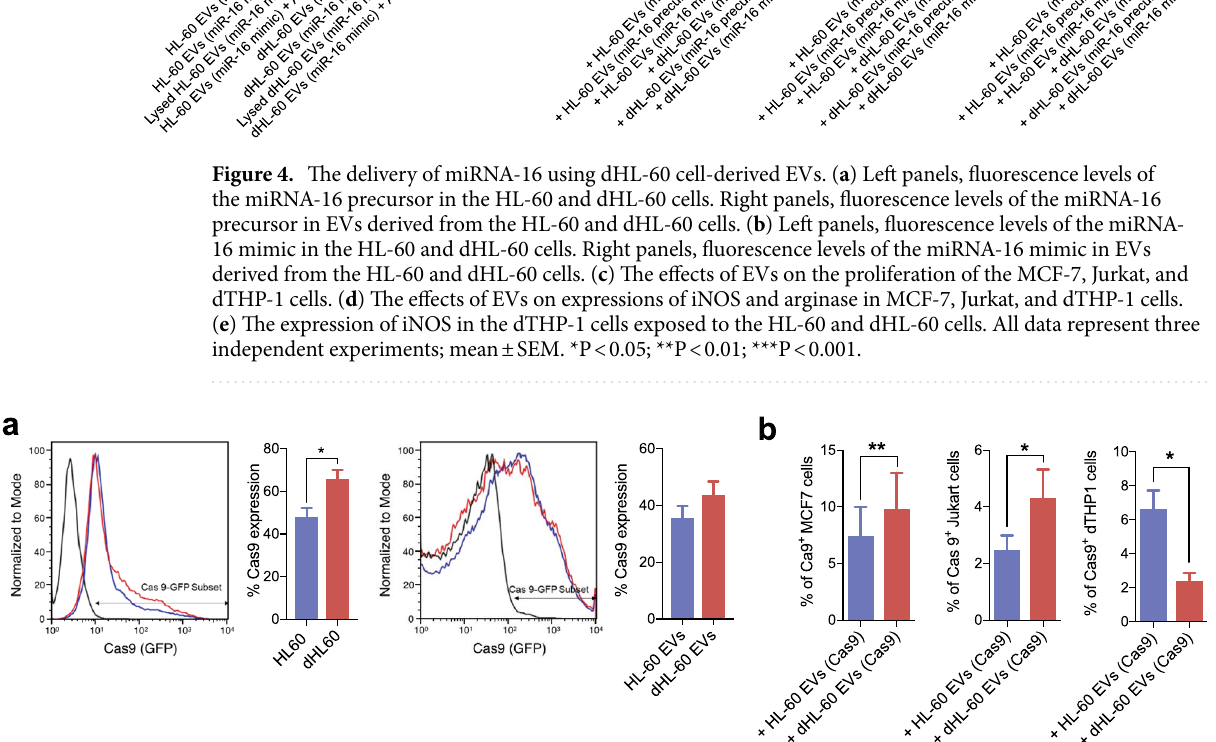
Figure 5. The delivery of Cas 9-GFP using dHL-60 cell-derived EVs. ( a ) Left panels, fluorescence levels of Cas9 in the HL-60 and dHL-60 cells. Right panels, fluorescence levels of Cas9 in EVs derived from the HL-60 and dHL-60 cells. ( b ) Fluorescence levels of Cas9 in the MCF-7, Jurkat, and dTHP-1 cells exposed to EVs. All data represent three independent experiments; mean ± SEM. *P < 0.05; **P <